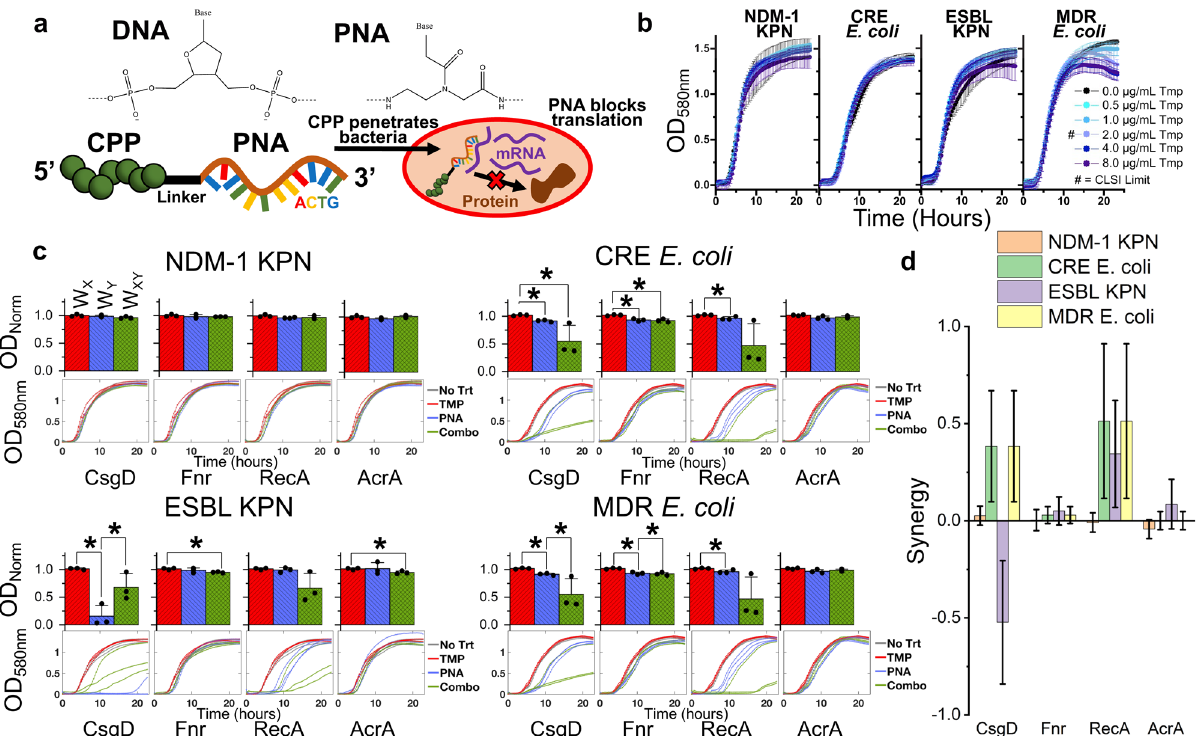
Fig. 6 PNA gene knockdown treatment resensitizes MDR clinical isolates to antibiotics. a Chemical structures of DNA and PNA show how the negatively charged phosphate backbone of DNA is replaced with a neutrally charged peptide backbone in PNA. These PNAs are conjugated to a CPP to enable penetration of bacterial membranes. Upon entry to the cell, PNAs complex with complementary mRNA to inhibit protein translation. b Resistance of MDR, clinically isolated bacteria to TMP above CLSI breakpoint levels of resistance, as demonstrated by growth curves unaffected by TMP concentration. Error bars represent standard deviation of four biological replicates. c MDR bacteria growth after exposure to 2 µ g/mL TMP (red bars, W X ), 10 µ M PNA (blue bars, W Y ), or both (green bars, W XY ). Bar plots (top) show growth in each condition normalized to blank wells and starting OD580 values and are subsequently normalized to the maximum growth in the absence of treatment. Growth curves (bottom) show OD580 values of individual biological replicates (3) over time with the minimum value subtracted. d Synergy values of PNA with TMP, grouped by speci fi c PNA targets. Error bars represent standard deviation of biological triplicates and black circles represent individual biological